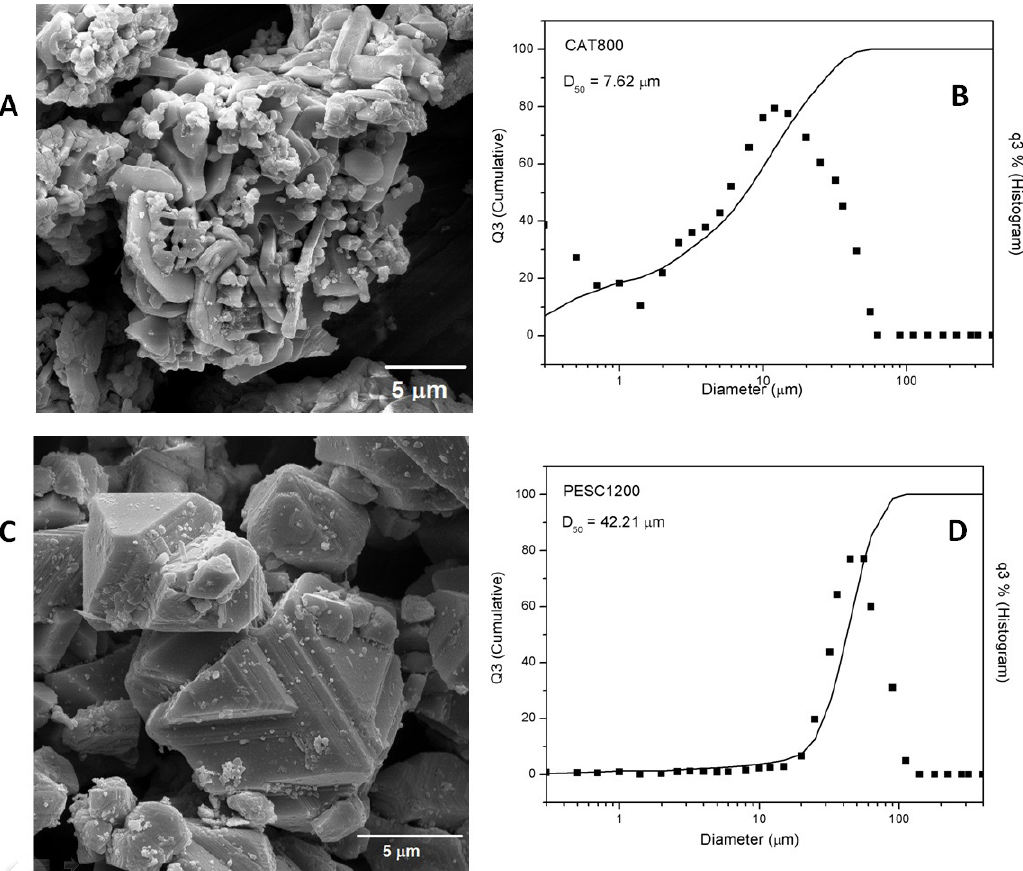
Figure 3. (A) Micrographs obtained by FE-SEM and (B) Particle size distribution of the CAT 800 sample, after heat treatment at 800°C. (C) Micrographs obtained by FE-SEM and (D) Particle size distribution of the CAT 1200 sample, after heat treatment at 1200°C.